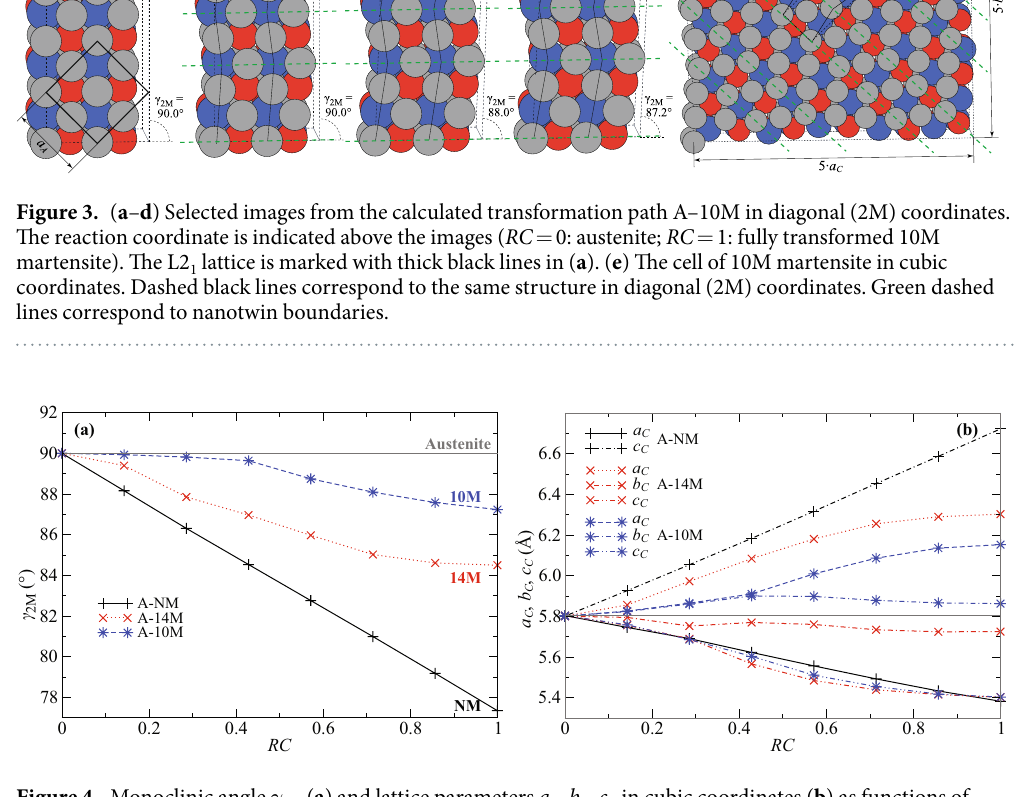
Figure 4. Monoclinic angle γ 2 M ( a ) and lattice parameters a C , b C , c C in cubic coordinates ( b ) as functions of reaction coordinate ( RC ) for A–10M, A–14M and A–NM transformation paths. The horizontal solid lines correspond to the lattice parameters of austenite. See Fig. 3 for the definitions of γ 2 M and a C , b C , c C